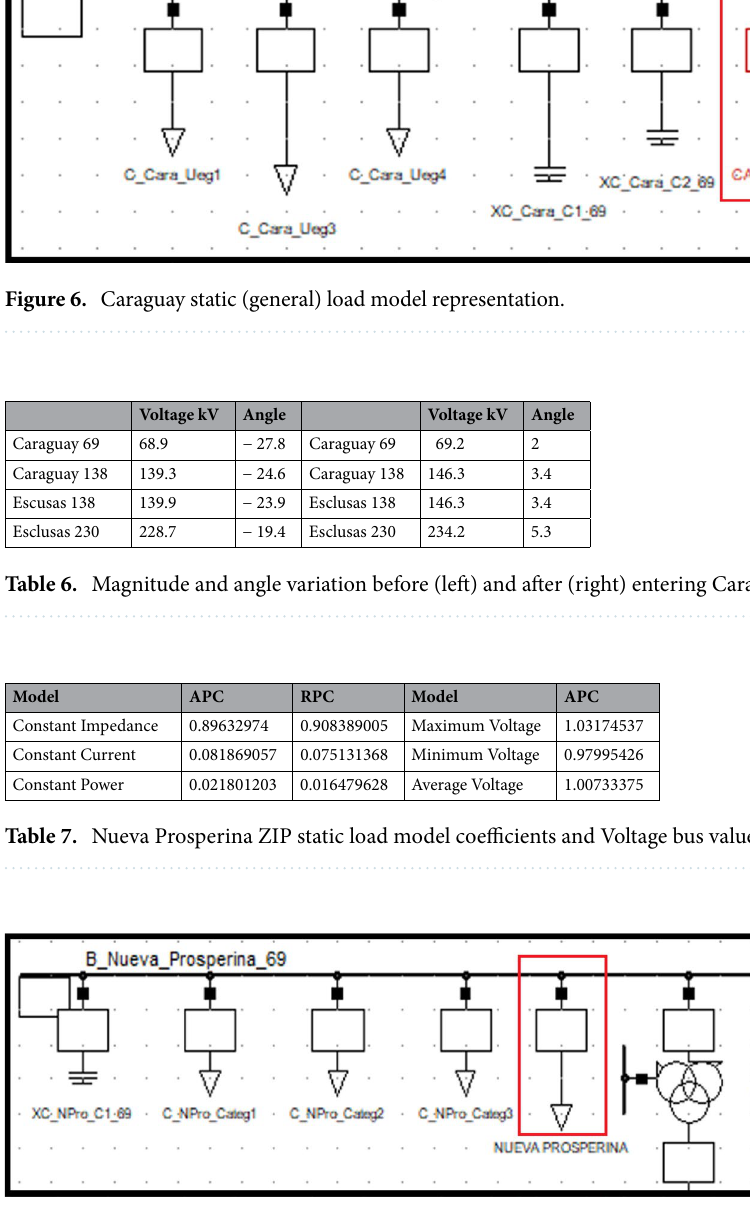
Figure 7. Nueva Prosperina static (general) load model